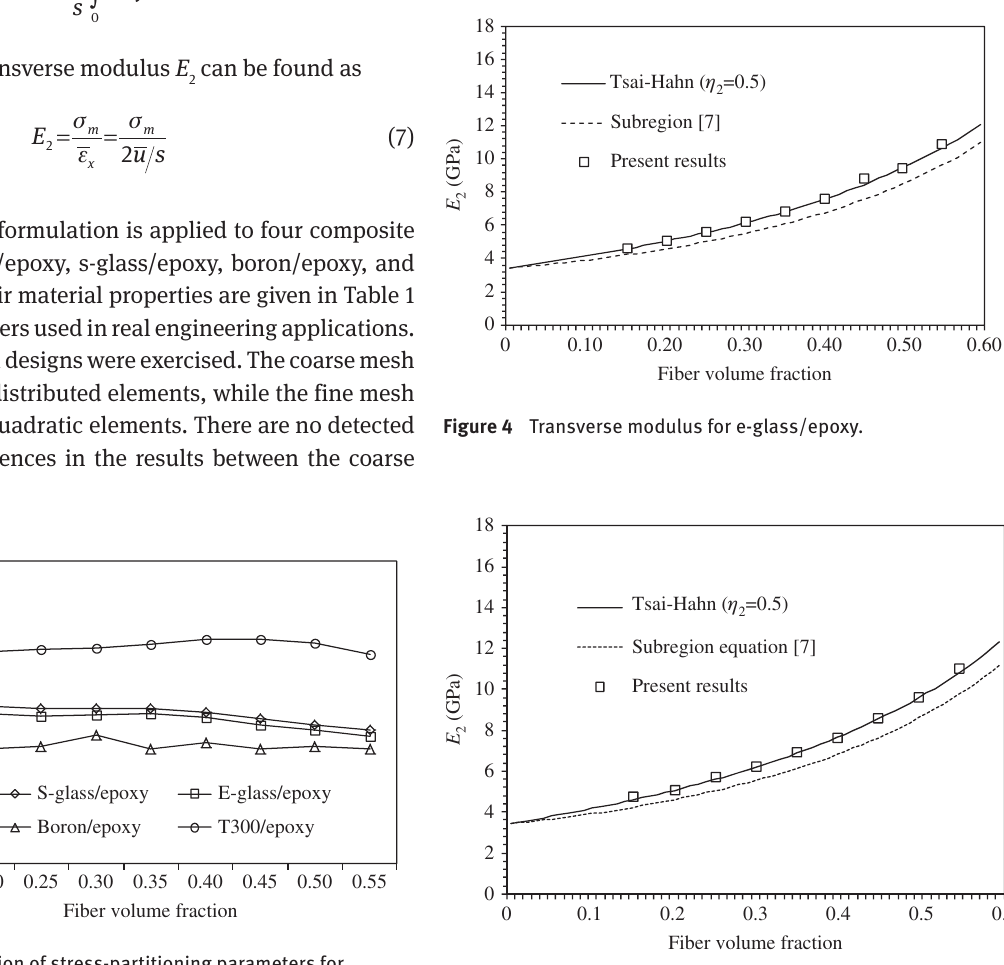
Figure 5 Transverse modulus for